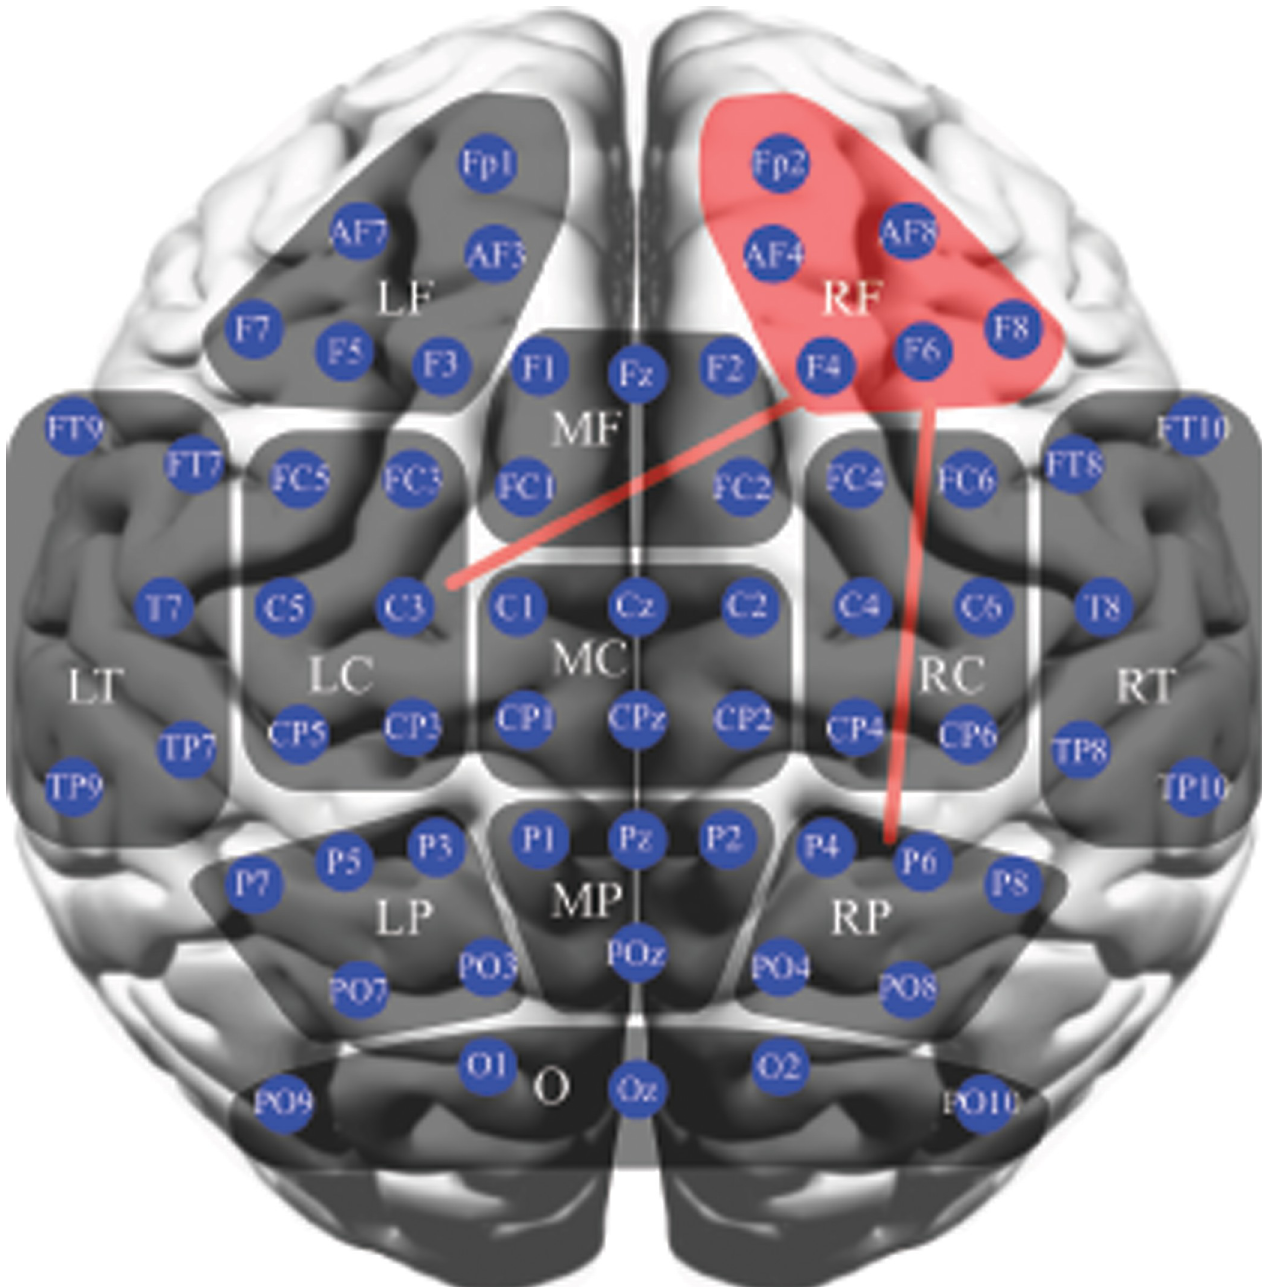
Fig 2. Schematic illustration of statistical analyses for regional average PLI (non-parametric permutation test; the significant difference is indicated by red region) and regional PLI (non-parametric permutation test; the significant difference is indicated by red line) in the delta band. The regional average PLI significantly decreased over the right frontal region in MCI patients. Also, the regional PLI significantly decreased between the right frontal and left central, and between right frontal and right parietal regions.